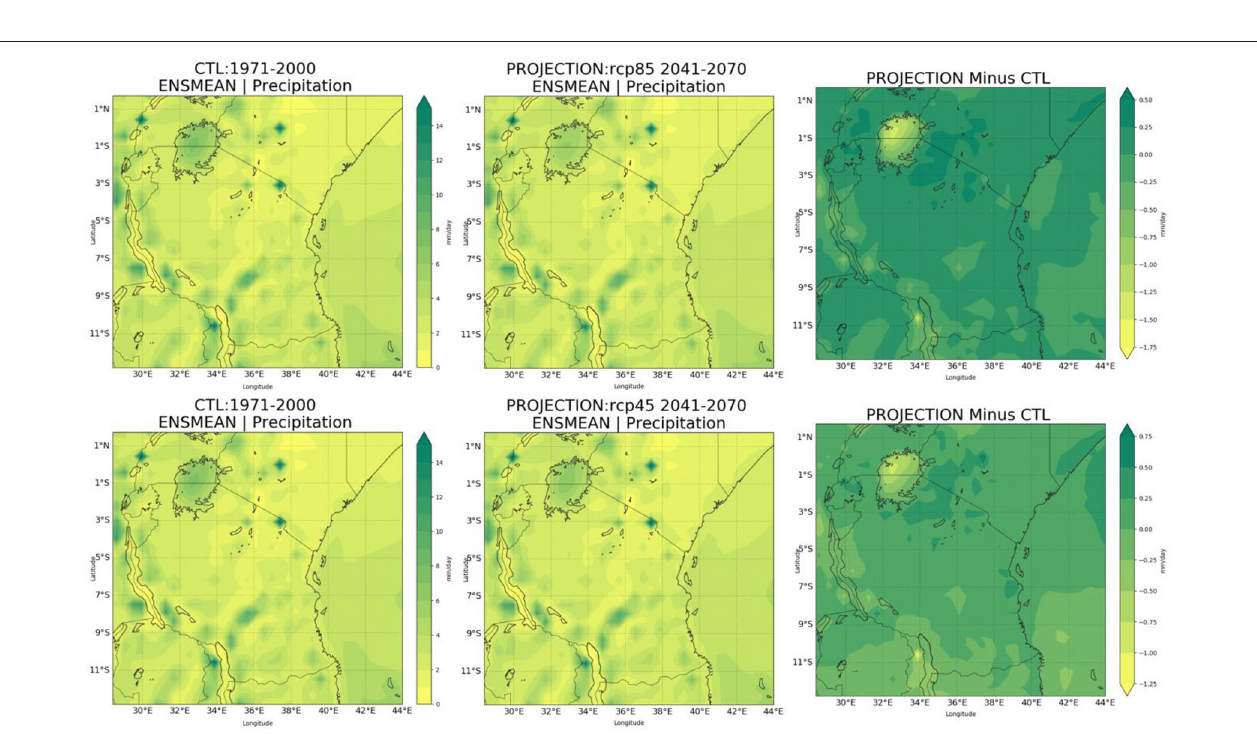
FIGURE 10 | Precipitation in mm/day during base period (1971–2000), present century (2041–2070), and change in precipitation under both RCP8.5 (upper) and RCP 4.5 (lower) .